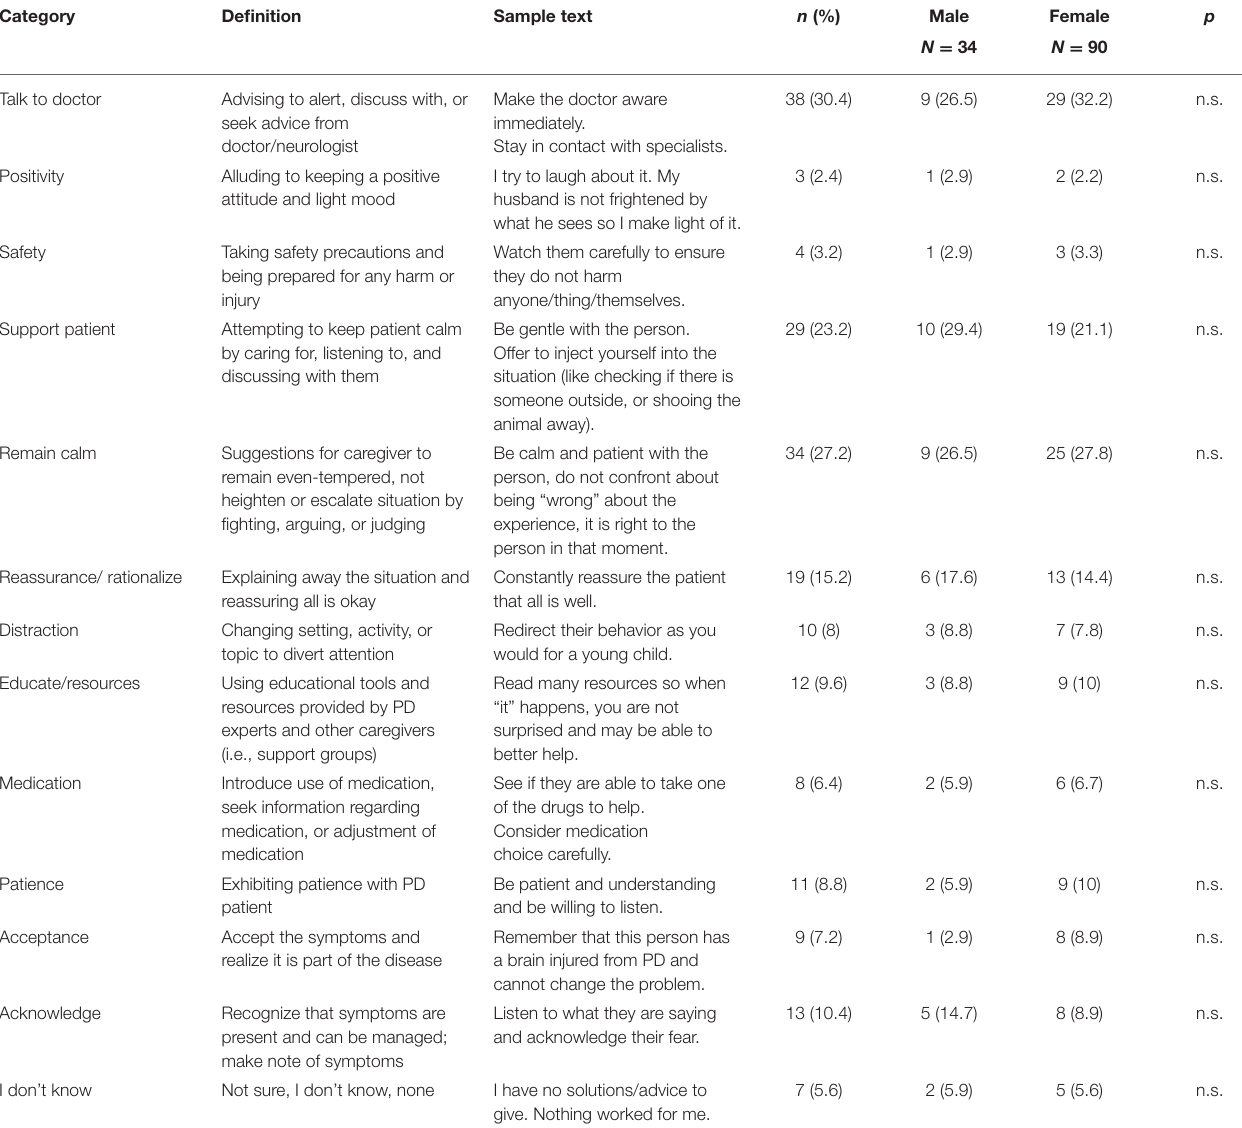
TABLE 2 | Codebook for peer advice regarding psychosis ( N =